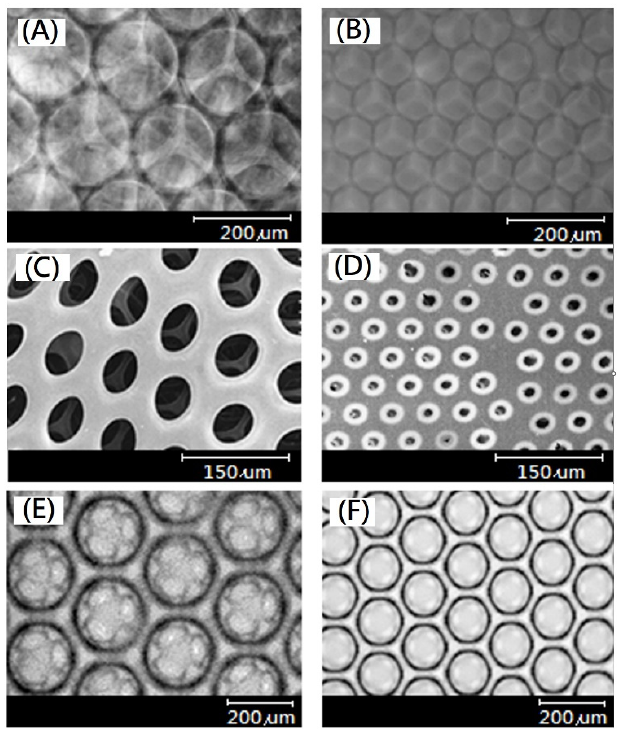
Figure 10. SEM morphology of chondrocyte grown on EDC-crosslinked gelatin-based hydrogel scaffold after dynamic culture, wherein ( A ) surface (scale bar = 200 μ m) and ( B ) cross section (scale bar = 50 µ m) after 7 days, ( C ) surface (scale bar = 2 00 µ m) and ( D ) cross section (scale bar = 50 µ m) for 14 days, and ( E ) surface (scale bar = 200 μ m) and ( F ) cross section (scale bar = 50 μ m) for 21 days.